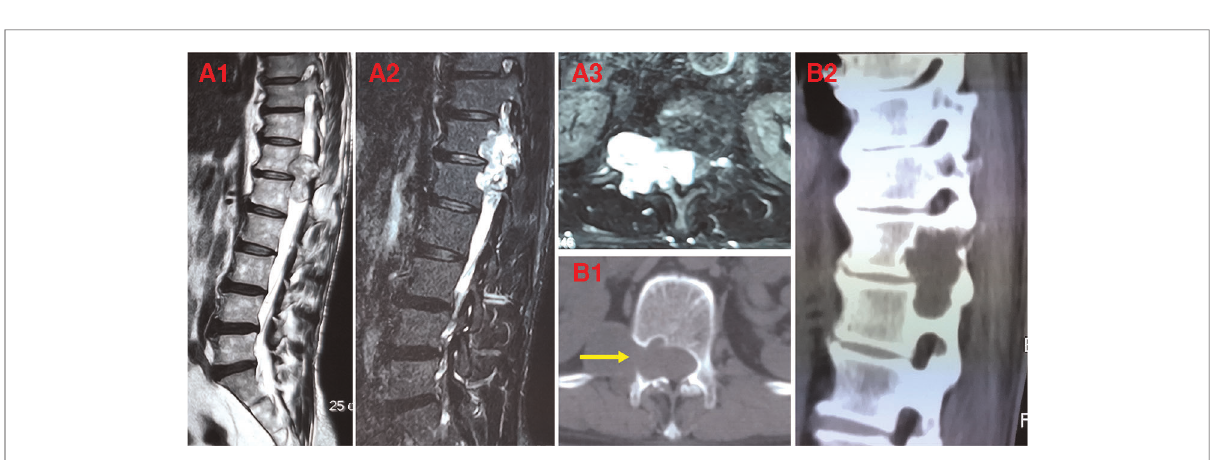
FIGURE 2 Preoperative MRI and CT showed thoracic dumbbell-shaped tumor of a 58-year-old male patient (case 15) ( A,B ). ( A1 , A2 ) sagittal MRI; ( A3 ) axial MRI; ( B1 ) axial CT; ( B2 ) sagittal CT. The pedicles of adjacent vertebra to thoracic dumbbell-shaped tumor (T12/L1) were involved and damaged. The yellow arrow indicates the damaged